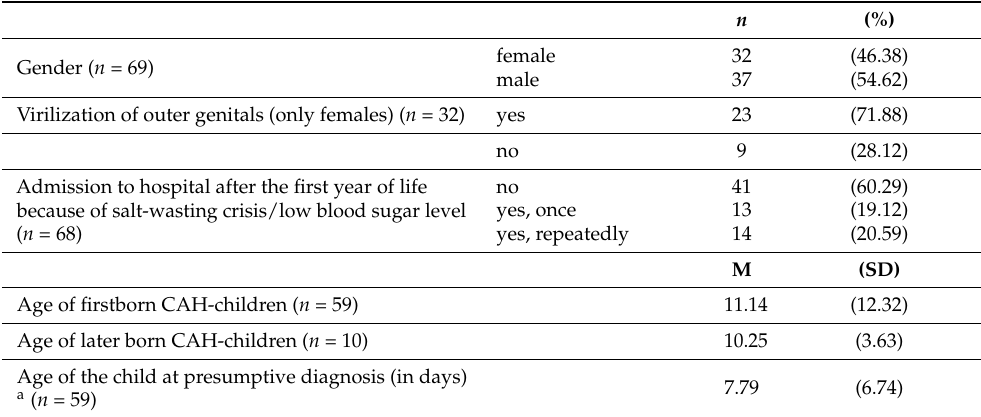
Table 2. Data of Childrens’ Characteristics ( n = 69).